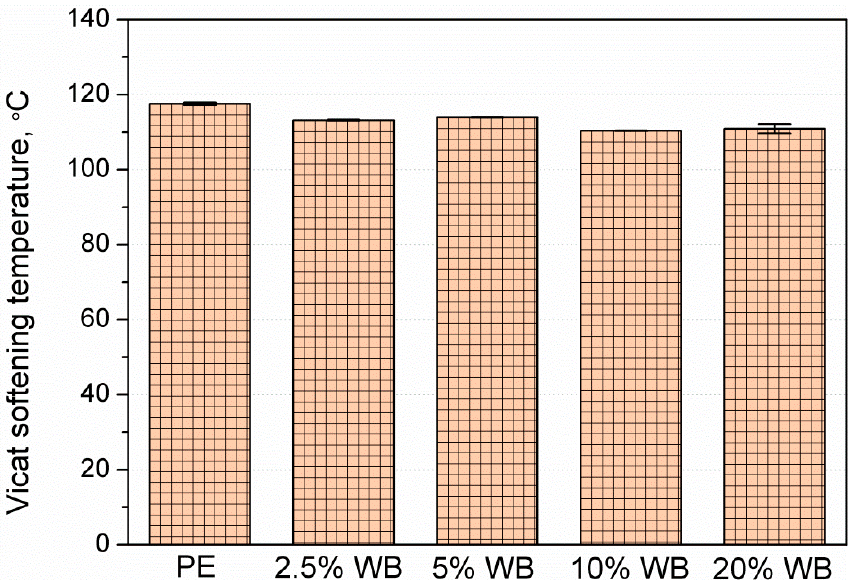
Figure 15. Vicat softening temperature values of rotationally molded PE and PE-WB Figure 15 . Vicat softening temperature values of rotationally molded PE and PE-WB composites.